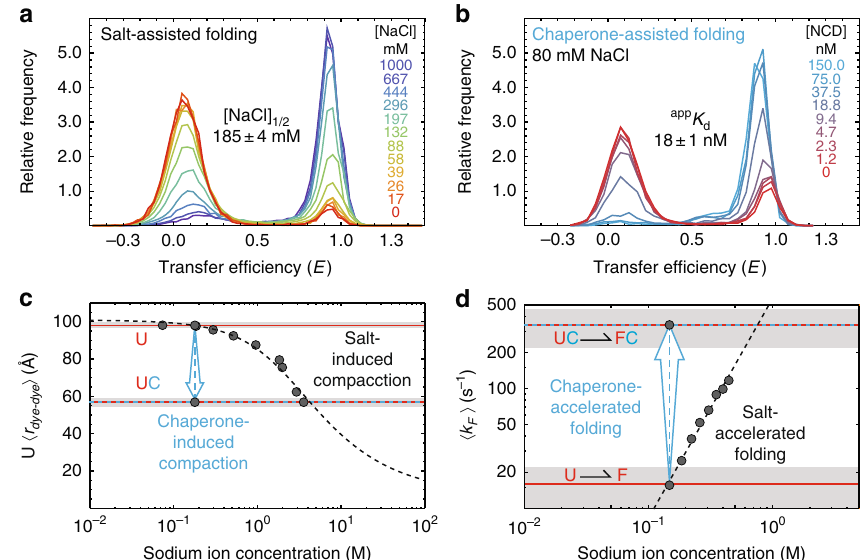
Fig. 4 NCD functions as a macromolecular counterion. Transfer ef fi ciency histograms for a salt-assisted and b chaperone-assisted folding of the 5 ′ -3 ′ FRET-labeled DNA hairpin. Increasing concentrations of either NaCl or NCD promote formation of the hairpin, but the transition midpoint concentrations (i.e., app K d and [NaCl] 1/2 ) for the two species differ by a factor of ∼ 10 7 . c Mean inter-dye distance for the folding-incompetent hairpin as a function of sodium ion concentration. Source data for mean values are provided as a Source Data fi le. The compaction of the unfolded nucleic acid induced by chaperone binding (cyan arrow) is comparable to that present at molar concentrations of NaCl. The dashed black line results from a fi t to a worm-like chain with a salt-dependent (i.e., electrostatic) persistence length (see Methods section). d Mean folding rate constant for hairpin formation as a function of NaCl concentration. Source data for mean values are provided as a Source Data fi le. Chaperone binding gives rise to a folding rate constant comparable to solutions containing molar concentrations of NaCl (cyan arrow). The extrapolation (dashed black line) is a fi t of the data to a power law of the form f